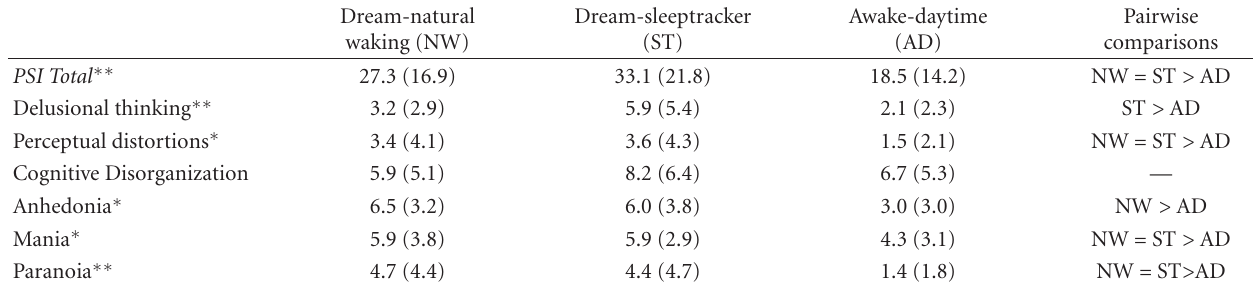
Table 1: Means and standard deviations of PSI and